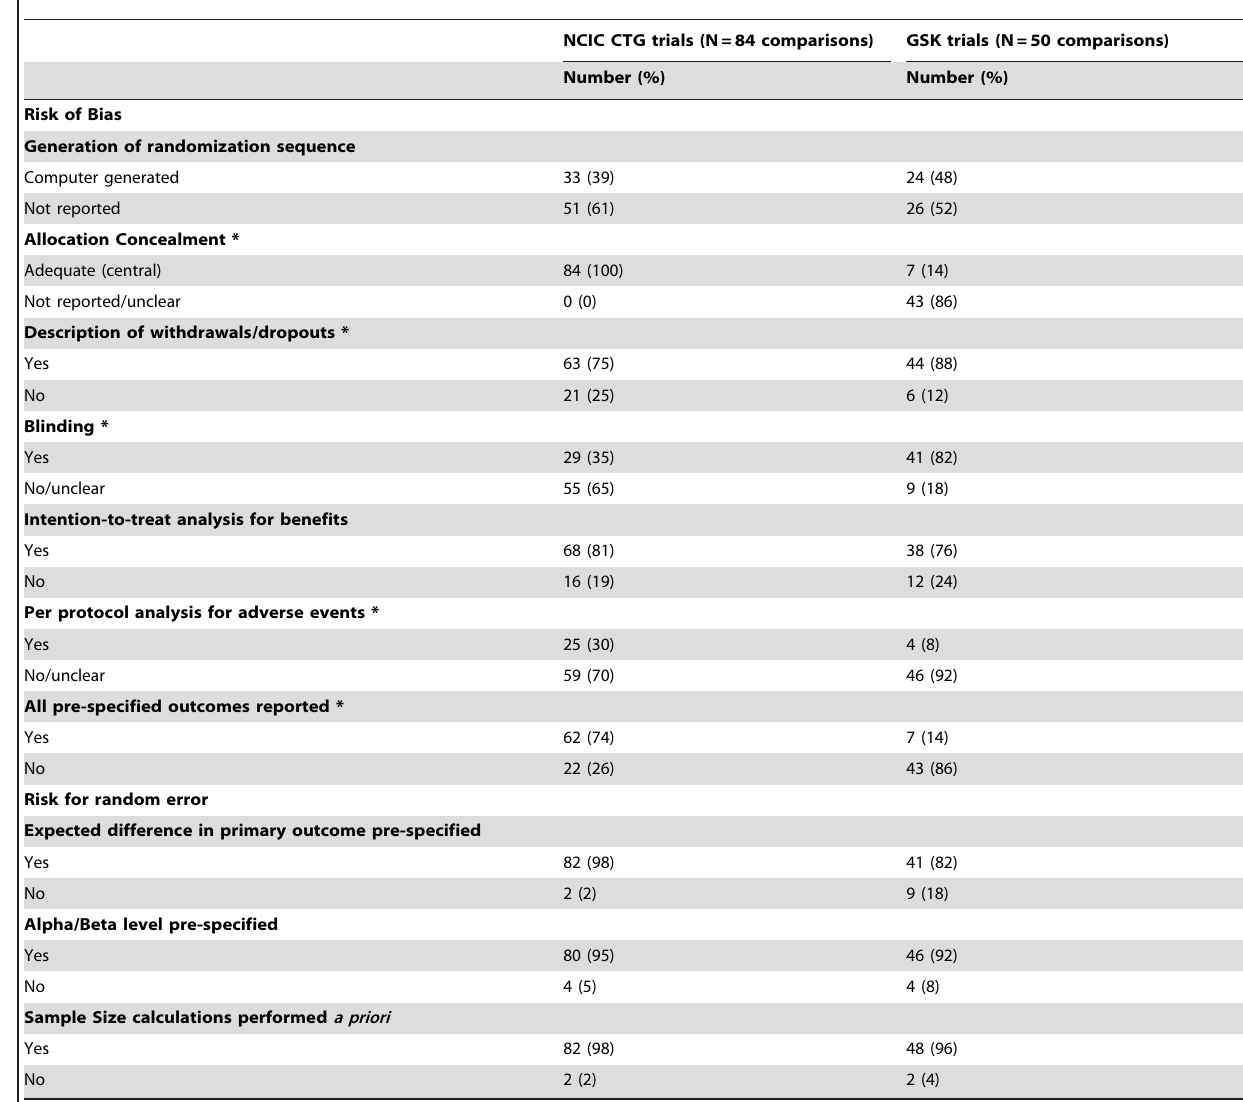
Table 2. Methodological quality of included trials conducted by National Cancer Institute Canada Clinical Trials Group (CTG) and GlaxoSmithKline